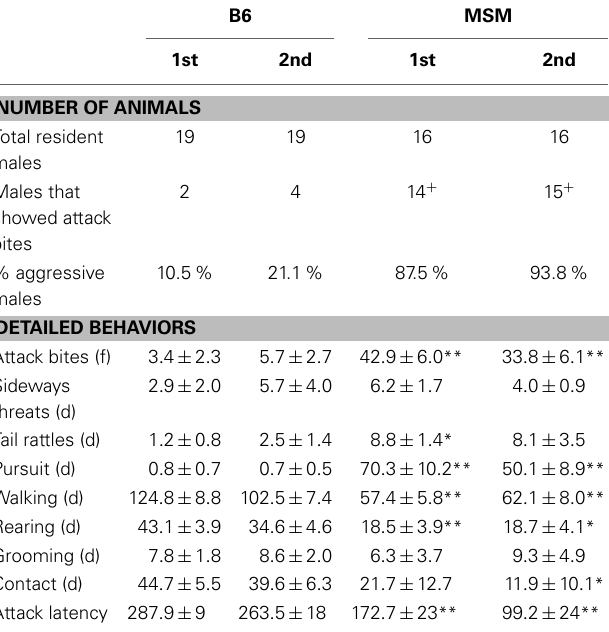
Table 1 | Resident-intruder test in MSM and B6 males.